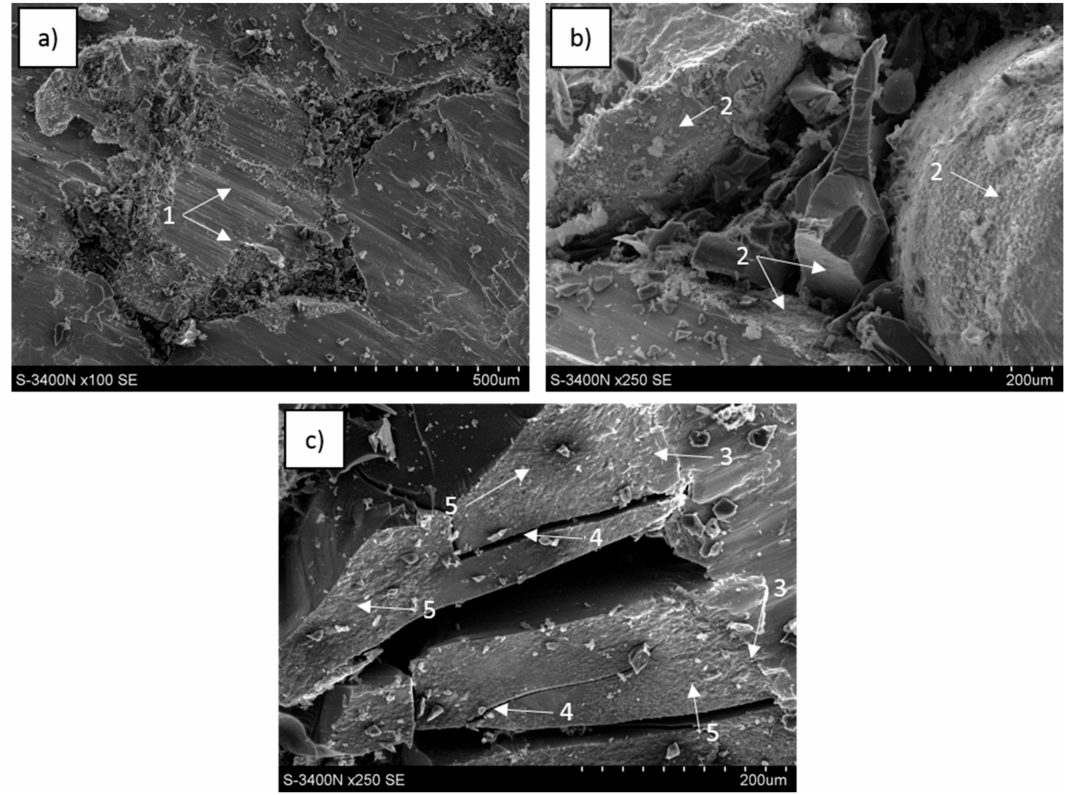
Figure 10. SEM images of C of 45ppi–AZ31 composite fractured during compression strength testing: ( a ) metal areas with shear bands (1) surrounded with degraded cells of carbon foam, ( b ) particles of refined carbon foam and metal surface after delamination from the foam, both locally coated with a layer of fine phases (2), ( c ) glassy carbon bonded with matrix (3), fragmented by microcracking (4) and locally (5) coated with fine phases formed in contact with liquid matrix and after